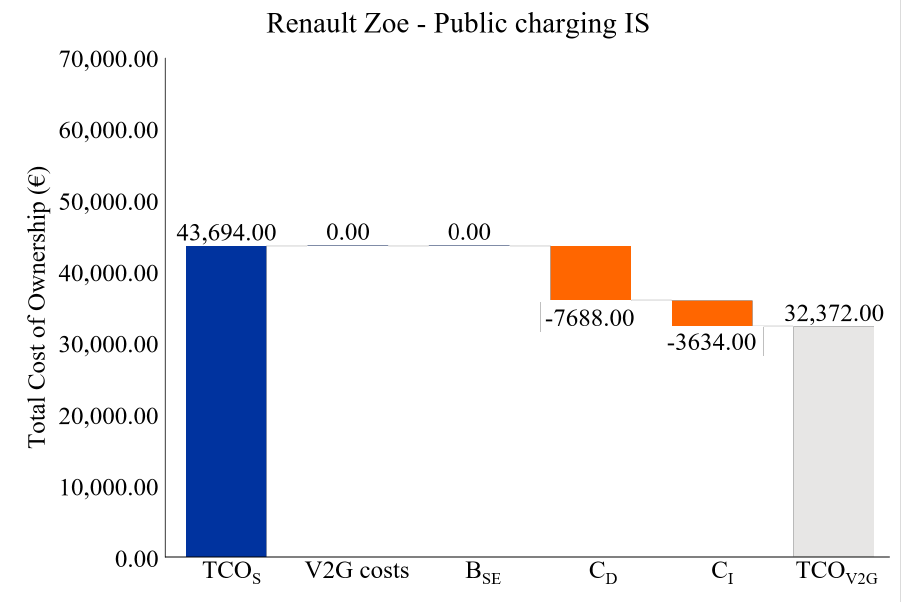
Figure A6. Standard and V2G TCO of a Renault Zoe in a public charging case providing IS ( TCO S = Standard TCO, B SE = benefit of saved electricity costs from the grid, C D = direct com- pensation, C I = indirect compensation, TCO V 2 G = V2G TCO); source: own compilation).